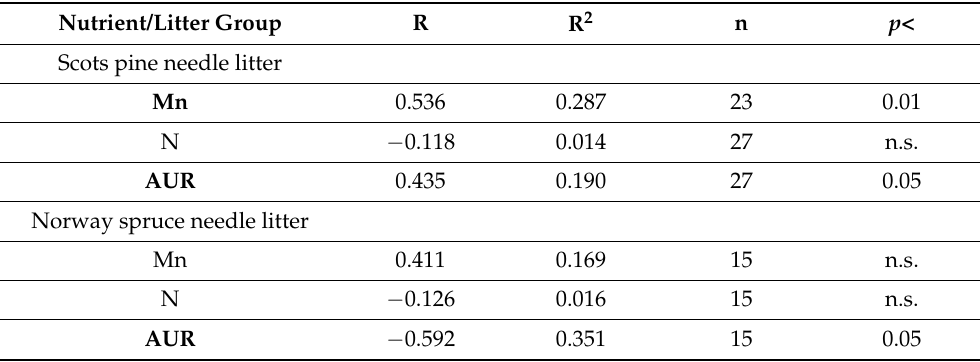
Table 2. Regressions between limit values and initial concentrations in litter of Mn, N, and AUR. All available data from the DELILA II data base (http://149.156.165.8/deco/) accessed on 15 July 2021 were used and subdivided into the main groups of natural Scots pine and Norway spruce litter. Best fit of linear, exponential and power functions are given. Bold text indicates a significant relationship. Modified from